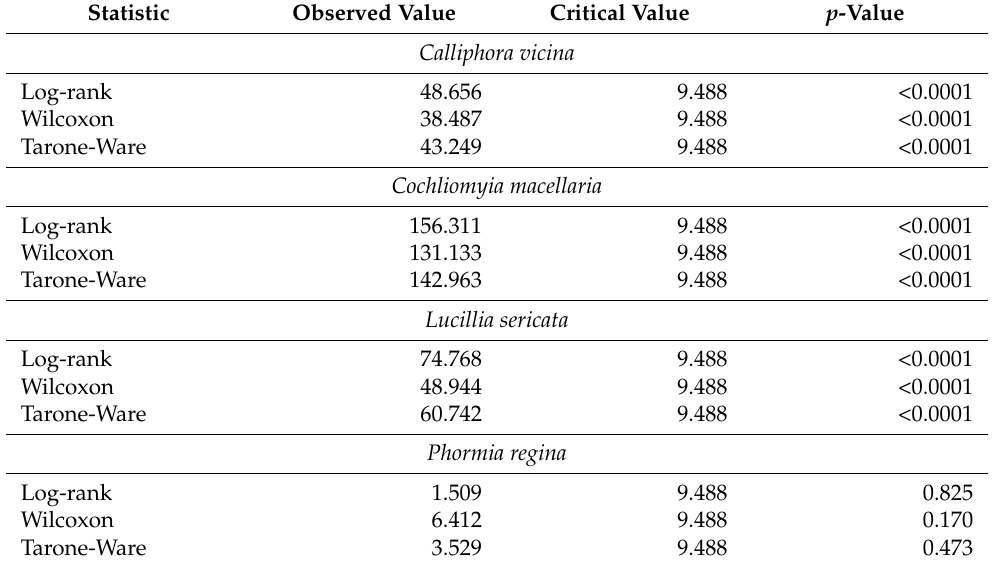
Table 1. Tests of equality of survival distribution functions by Log-rank, Wilcoxon, and Tarone- Ware tests. Survival distribution functions from Kaplan–Meier survivorship analysis of anoxia survivorship by time at different temperatures, for 3rd-stage larvae of each of four species: Calliphora vicina , Cochliomyia macelleria , Lucilia sericata , and Phormia regina .